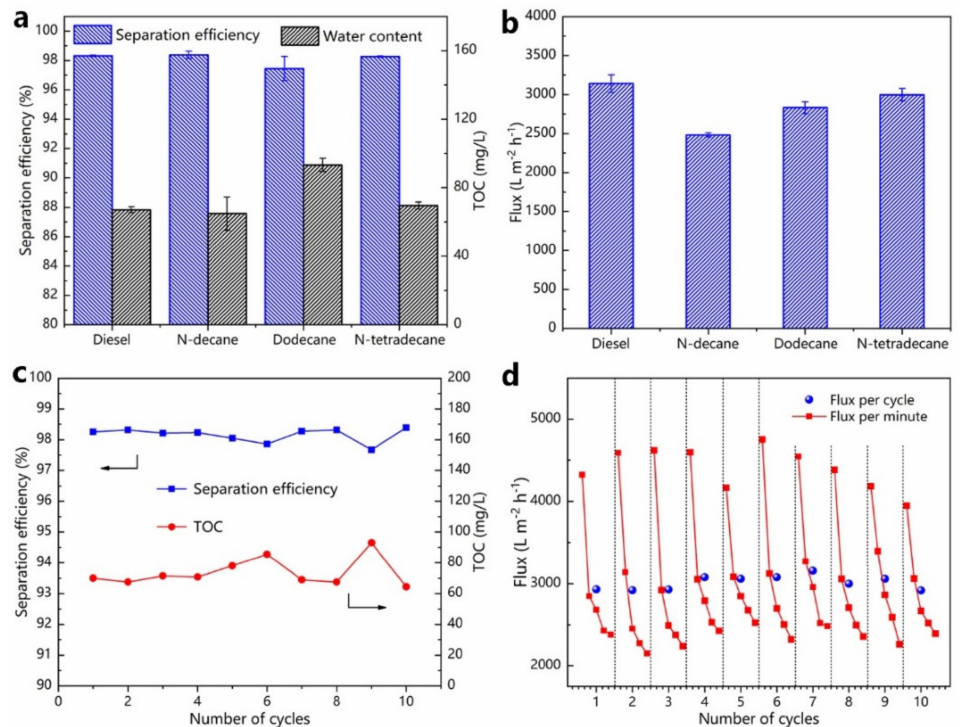
Figure 7. ( a ) The separation efficiency and TOC in the filtrates of oil-in-water emulsions; ( b ) var- ious oil-in-water emulsion separation fluxes; ( c ) the recycling separation of the as-prepared filter membrane for O/W emulsions; ( d ) separation flux stability in 10-cycle